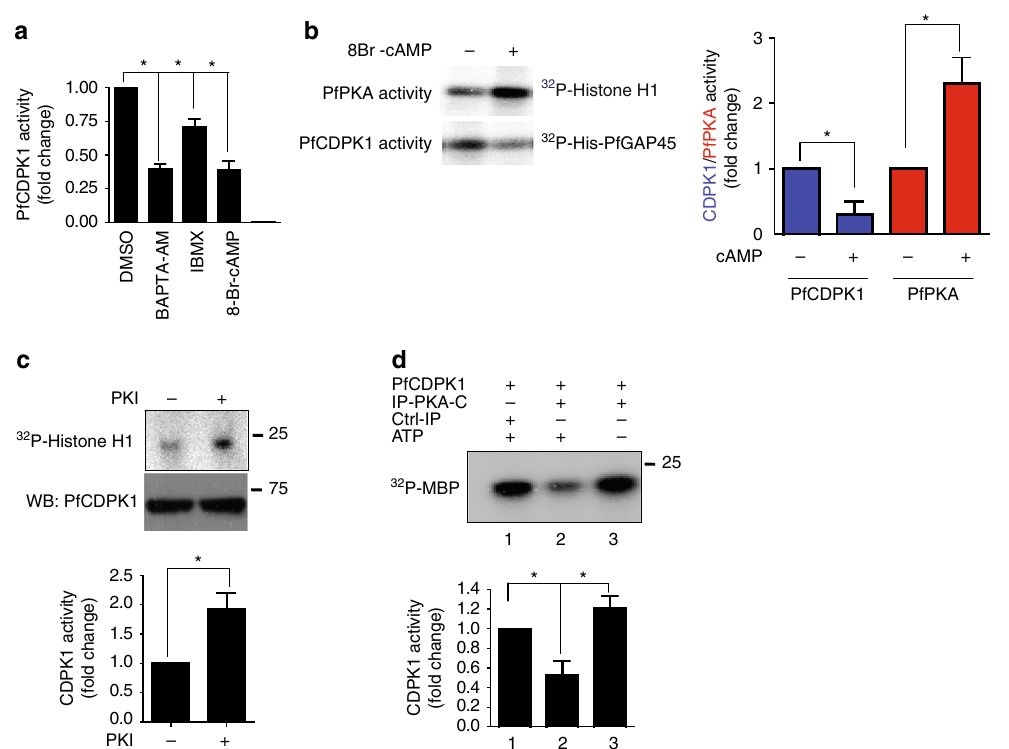
Fig. 4 cAMP-dependent PfPKA-signaling may prevent PfCDPK1 activation via a negative feedback loop. a 3D7 schizonts were treated with